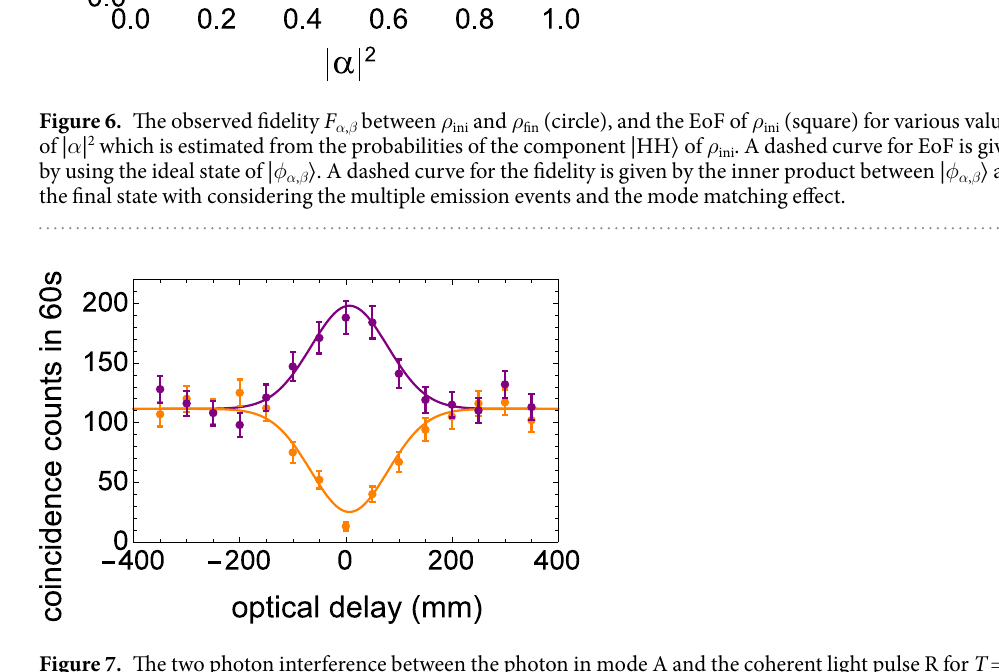
Figure 7. The two photon interference between the photon in mode A and the coherent light pulse R for T =